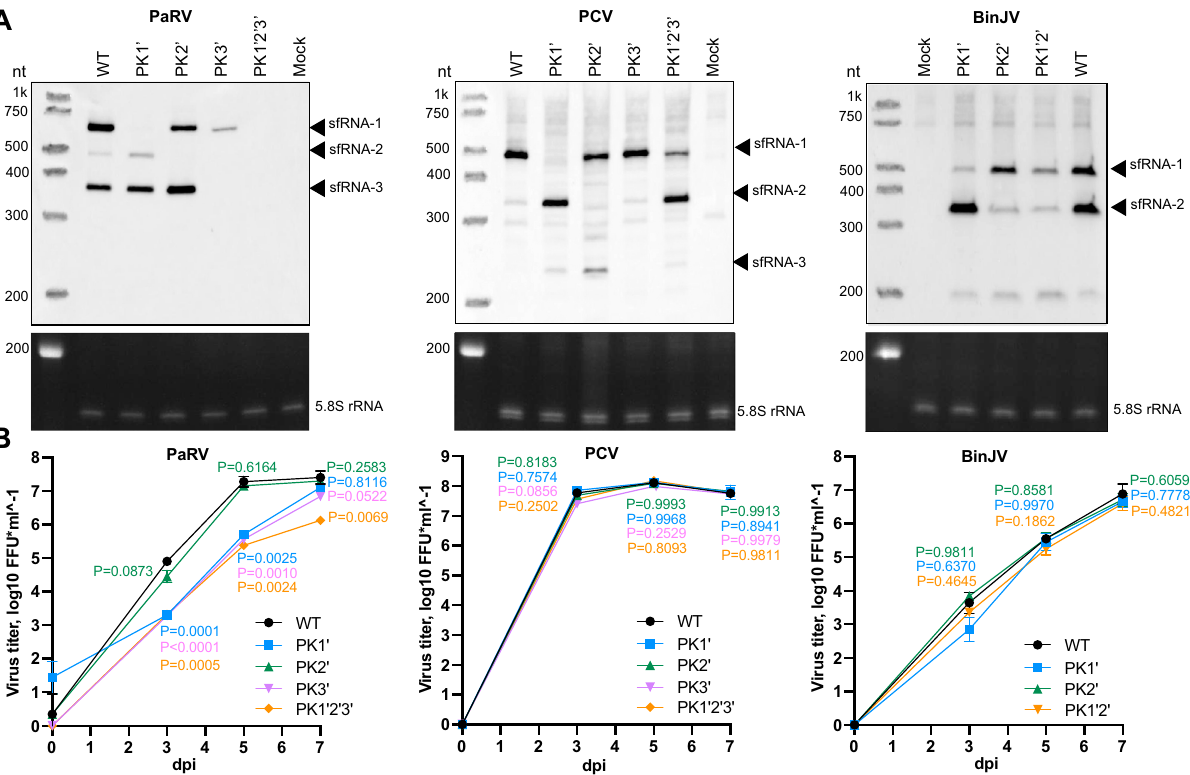
Fig. 7 Effect of sfRNA de fi ciency on replication of ISFs in mosquito cells. A Northern blot analysis of sfRNA production by WT and PK mutants of PARV, PCV and BinJV. C6/36 cells were infected with WT or mutant viruses at MOI = 1. Total RNA was isolated at 7 dpi and used for blotting. The bottom panel show Et-Br-stained 5.8 S rRNA as an equal loading control. Images are representative of two independent experiments that produced similar results. PK1 ’ , PK2, and PK3 ’ mutations represented substitutions of PK-forming nucleotides in L2 loops of SLI, SLII and SLII, respectively, with complementary nucleotides and are the same as in Fig. 2D (BinJV), 3 C (PaRV), 3 G (PCV). B Virus titers in culture fl uids of RML-12 cells infected with WT or PK-mutants of ISFs. Cells were infected at MOI = 0.1, culture fl uids were sampled at the indicated time point, and titers were determined using foci-forming immunoassay on C6/36 cells. Values are the means from three biological replicates ± SD. Statistical analysis was performed by two-way ANOVA with Dunnett ’ s correction, all comparisons were to WT, test was